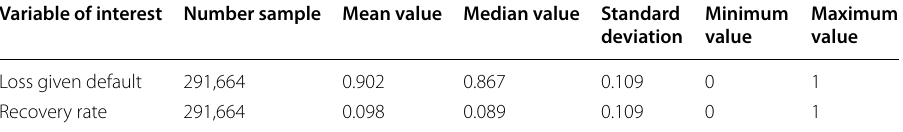
Table 6 Descriptive statistics of RR and